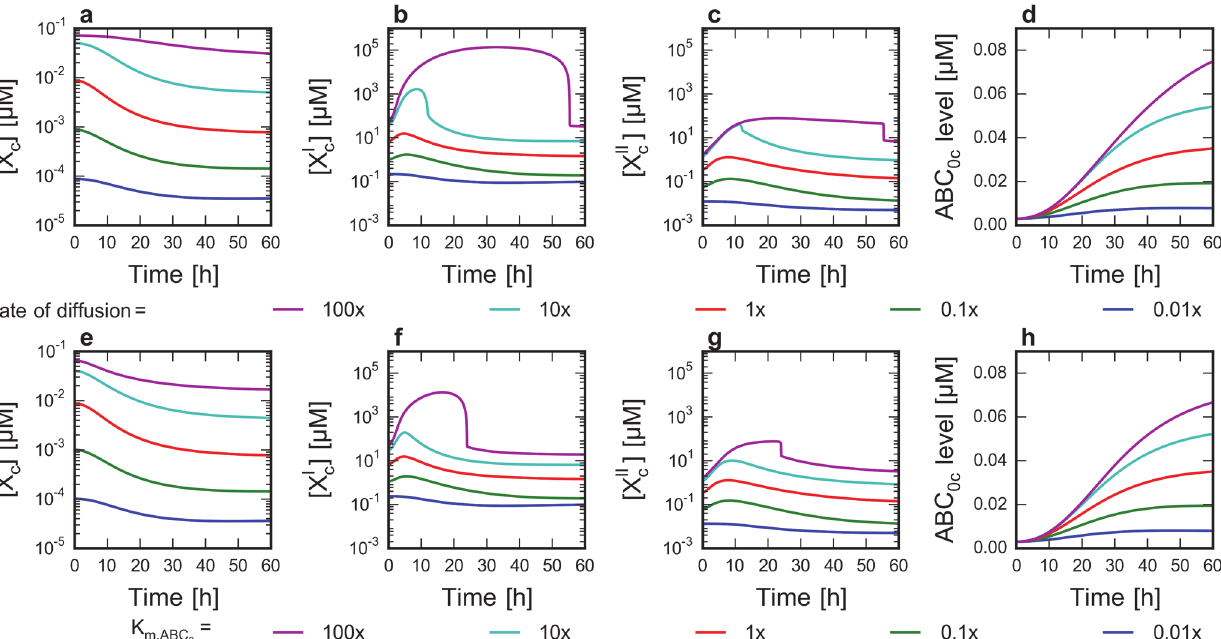
Fig 3. Effect of diffusion rate and ABC 0 affinity to drug on the level of network components. Time course simulations were run from steady states belonging to different parameter sets as described in Methods. The extracellular drug concentration ([X e ]) was set to 75 nM at t 0 = 0 h. Parameter values are expressed as multiples of their default value (S3 Table). Concentration profile of X c , X ’ c , X ” c and the level of ABC 0 were plotted. a-d Effect of diffusion rate through membranes. Five simulations were run by setting the diffusion rate constants to different values of four orders of magnitude. e-h Effect of ABC 0 affinity to drug (K m ). Five simulations were run by setting the Michaelis constant to different values encompassing four orders of magnitude.